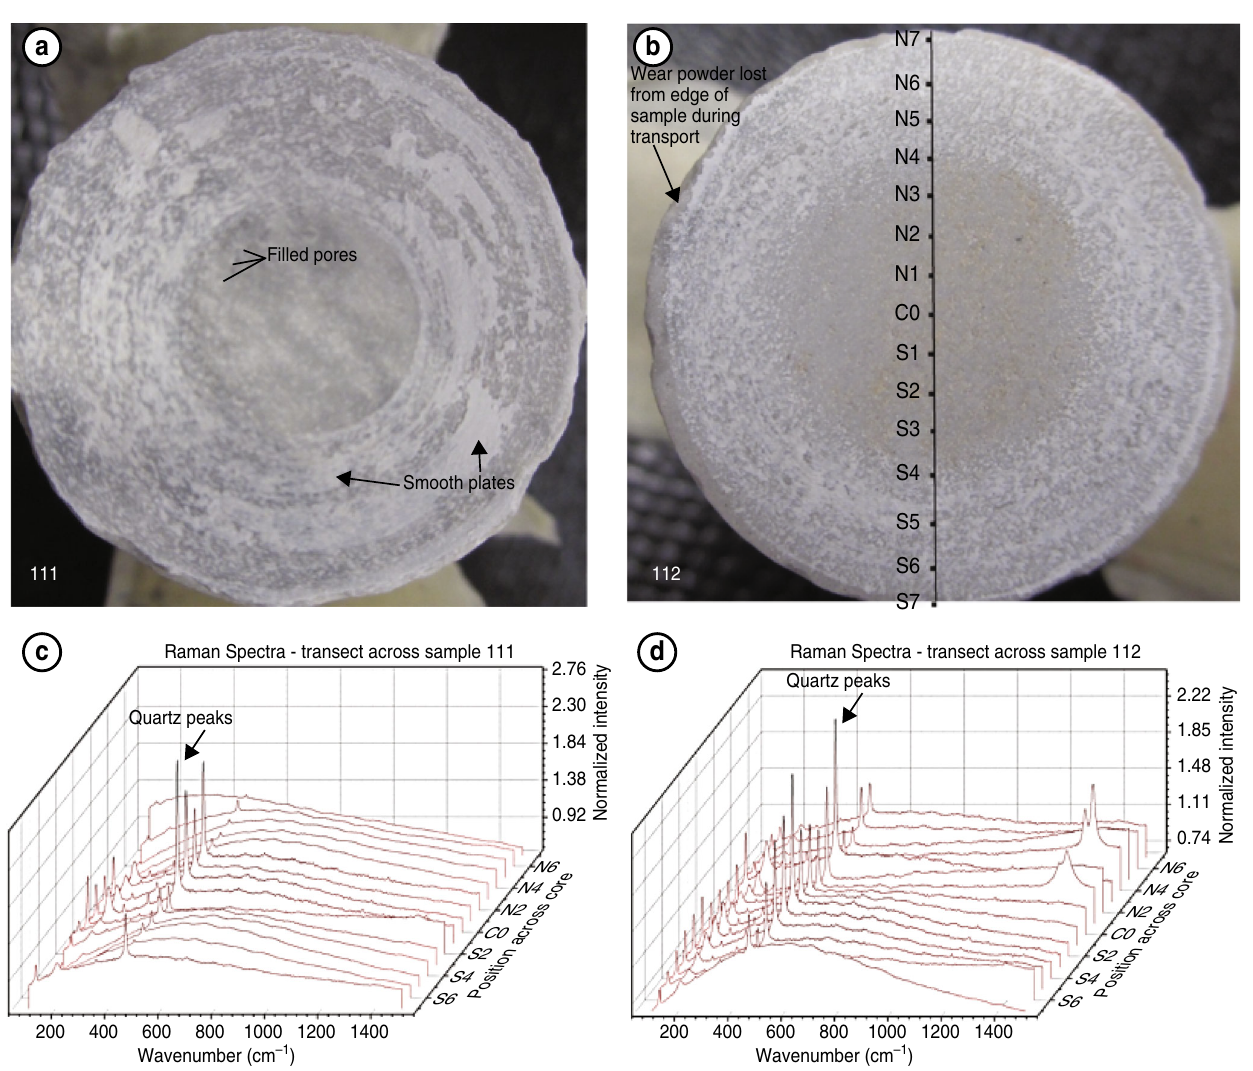
Fig. 6 Photos of shear surfaces and corresponding Raman spectra transects. a Sample 111 (1 cm/s), and b Sample 112 (100 µ m/s), showing discontinuous concentric rings of powder on sample surface. Raman spectra from transect scans are shown for each sample ( c corresponds to sample 111, d corresponds to sample 112). The appearance and disappearance of the sharp quartz peaks along the transect can be correlated to the amount of visible wear material in the photos. See text for additional discussion